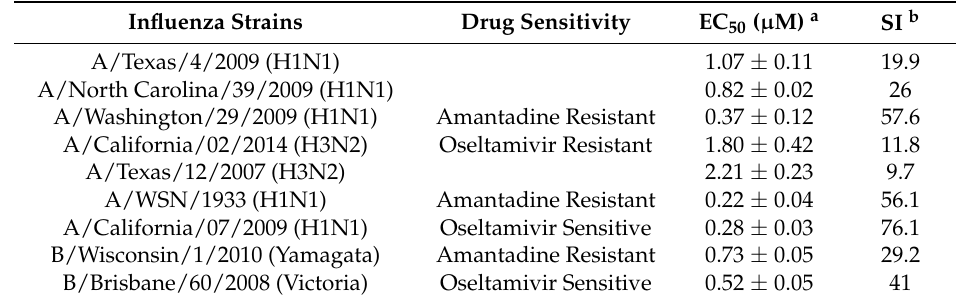
Table 1. EC 50 of hesperadin against a panel of influenza A and B viruses. Influenza